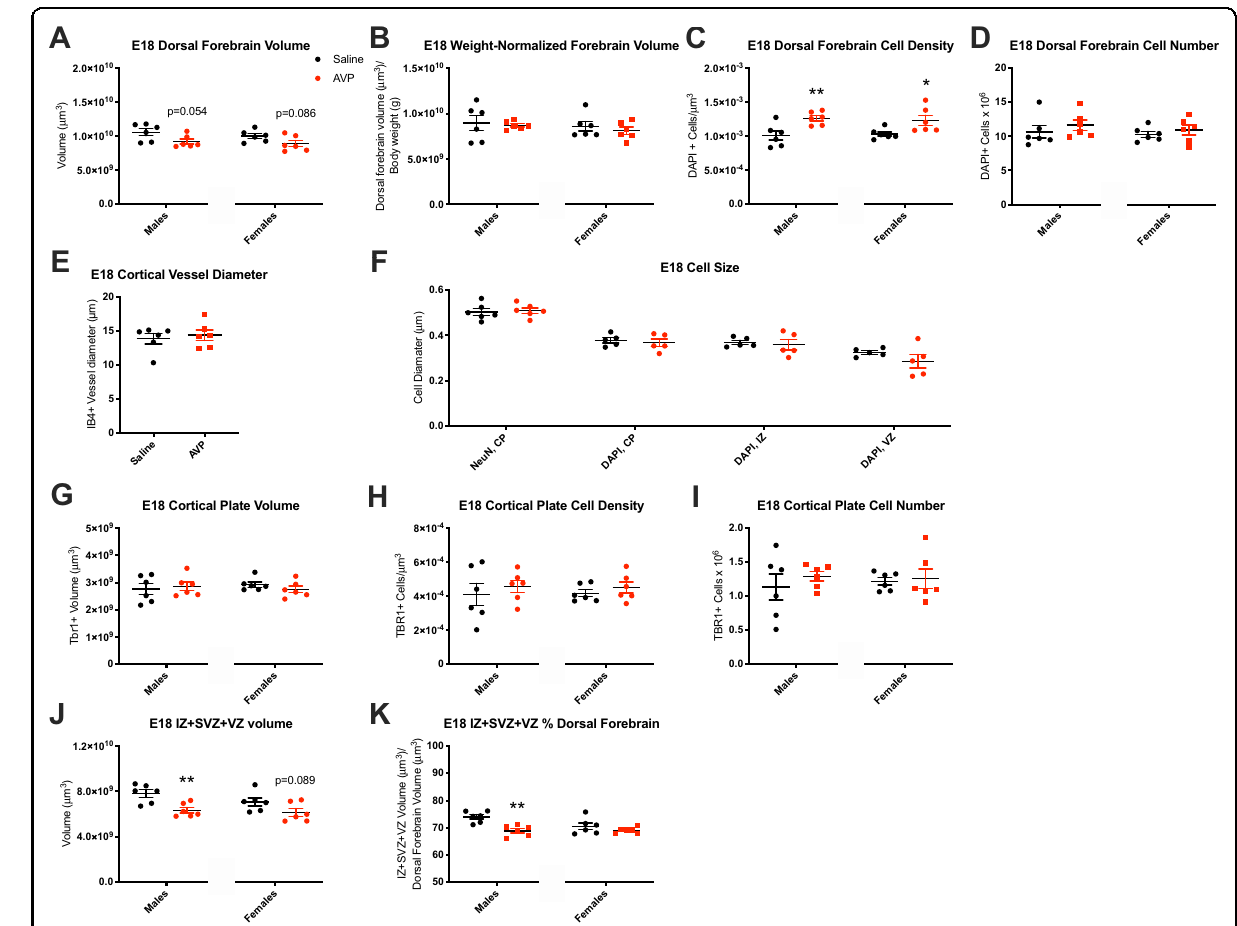
Fig. 4 Embryonic offspring neurobiology was altered by maternal AVP. a The embryonic day (E) 18 dorsal forebrain was trend-smaller in AVP- condition offspring (males: p = 0.054, females: p = 0.086), which re fl ected ( b ) symmetrical growth restriction relative to body weight decrements with AVP exposure. c Dorsal forebrain cell density signi fi cantly increased with AVP exposure in male and female offspring [males: p = 0.009, females: p = 0.035] such that ( d ) the total forebrain cell number was unchanged. These volume differences were not accounted for by ( e ) changes in cortical vessel diameter or ( f ) cell size across the cortical plate (CP), intermediate (IZ), or ventricular (VZ) zones. g The TBR1-labeled cortical plate volume, ( h ) cell density, ( i ) and cell number were unchanged with AVP. j The volume of the intermediate, subventricular, and ventricular zones (IZ + SVZ + VZ) was signi fi cantly smaller in E18 AVP-exposed male offspring and trend-smaller in AVP-exposed female offspring (males: p = 0.005, females: p = 0.089), ( k ) also re fl ected by a decreased proportion of dorsal forebrain occupied by IZ + SVZ + VZ in AVP-exposed males ( p = 0.001). * p < 0.05, ** p < 0.01 per two-sample t -test, error bars represent SEM. 3 litters per condition, 1 – 3 brains per sex per